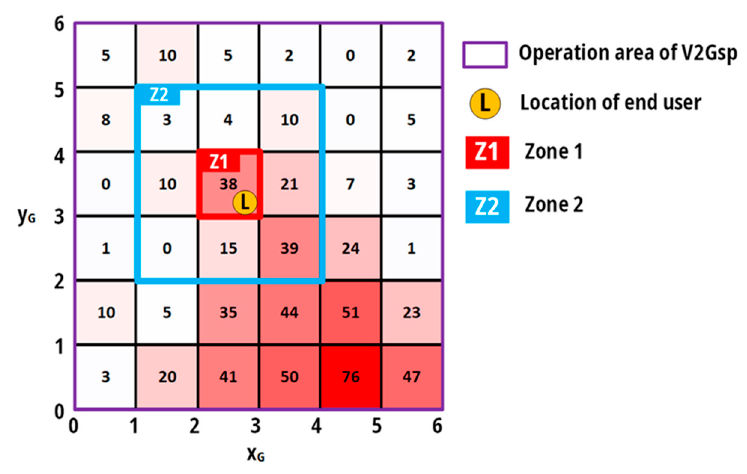
Figure 9. Zones for searching uEVs in the operation area of V2Gsp.